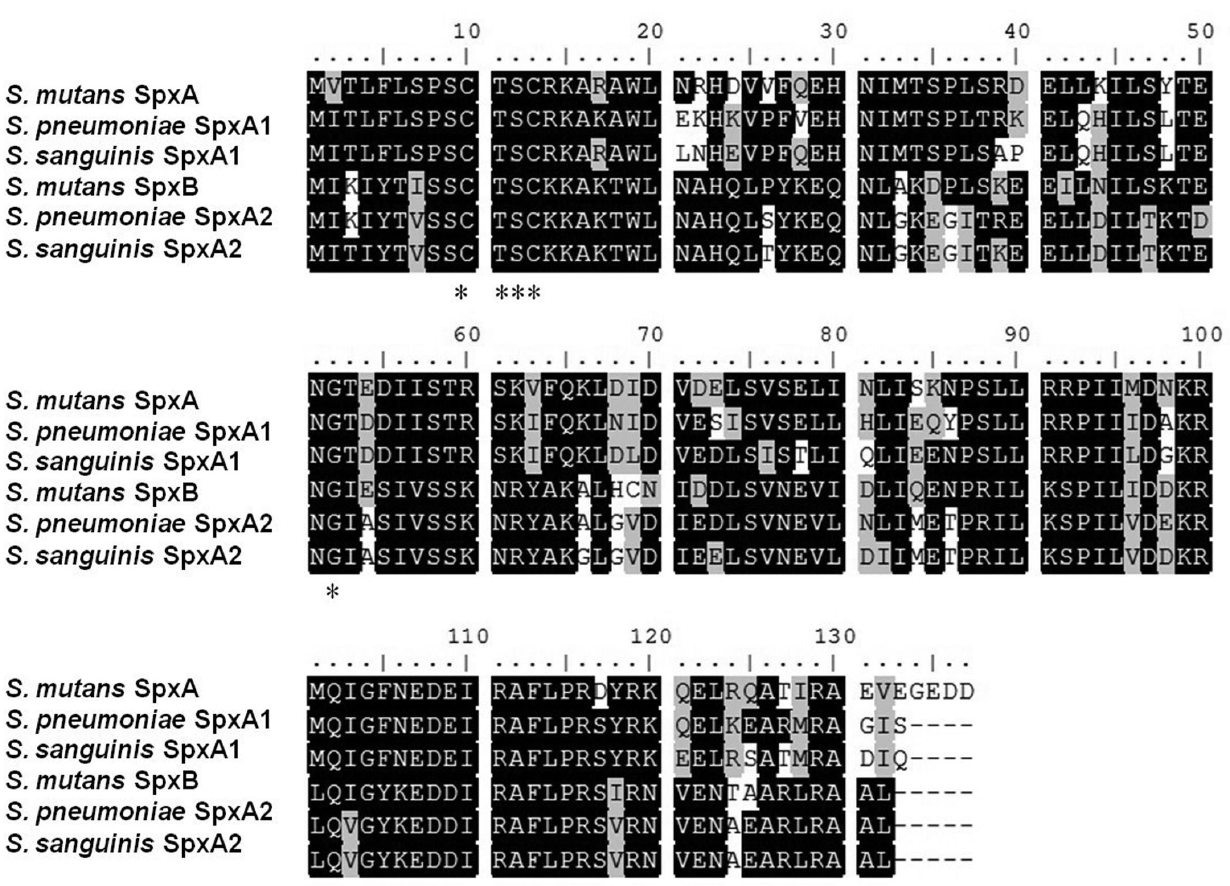
Figure 3. Alignment of amino acid sequences of the two Spx proteins from S.mutans , S.pneumonia and S.sanguinis . Identical residues are shaded in black and similar ones in gray. The conserved CXXC motif and Gly 52 residue discussed in the text are stars (*) labeled. The GenBank accession numbers: S. mutans SpxA, SMU.1142c; S. pneumonia SpxA1, SPR1262; S. sanguinis SpxA1, SSA_0937; S. mutans SpxB, SMU.2084c; S. pneumonia SpxA2, SPR0173; S. sanguinis SpxA2,